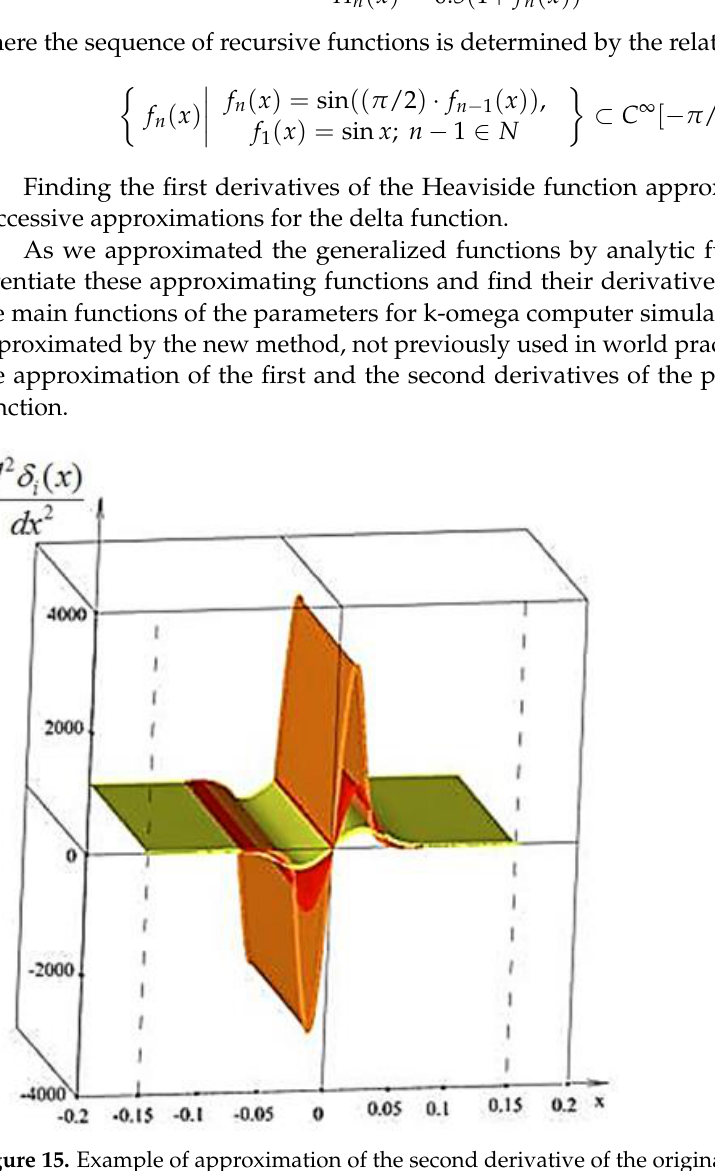
Figure 15. Example of approximation of the second derivative of the original delta function.